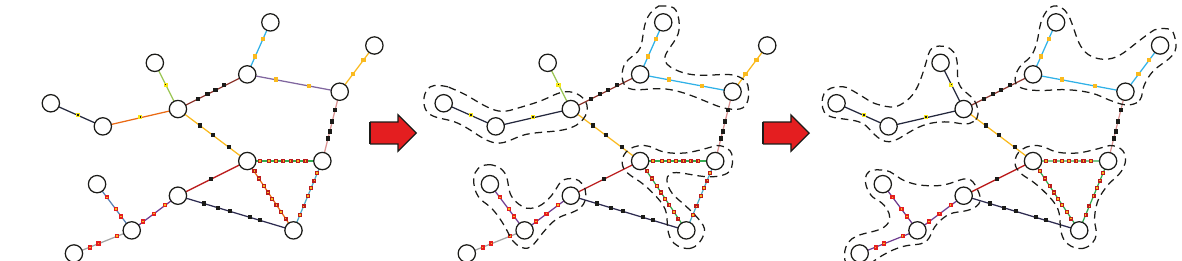
Figure 3: The process of the hierarchical